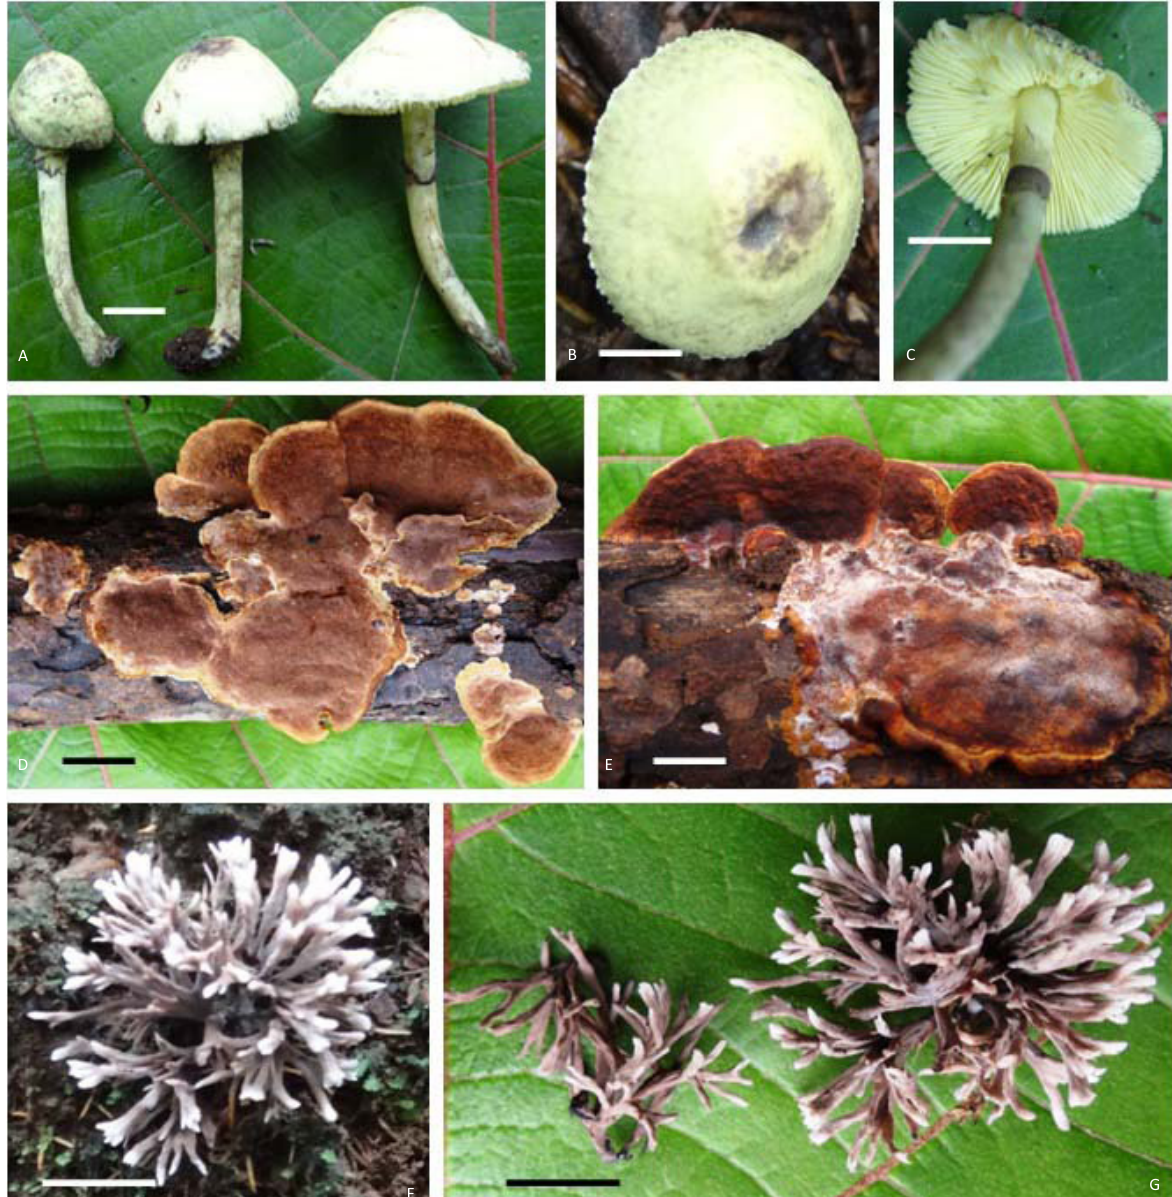
Occurrence and distribution: Rare in scrub